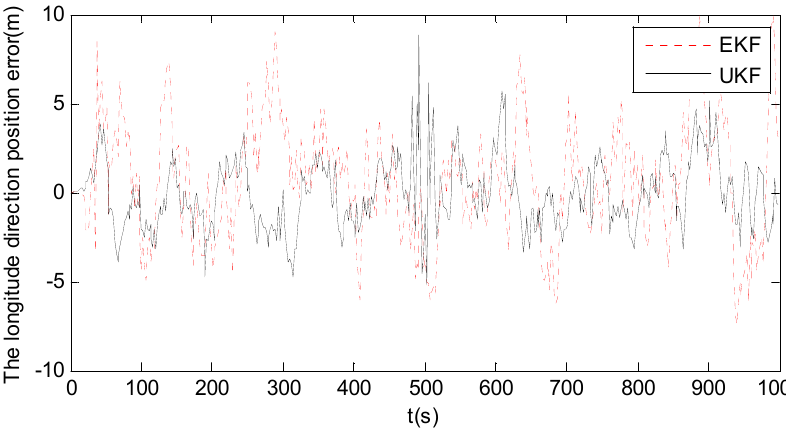
Figure 5. The longitude errors of EKF and UKF.